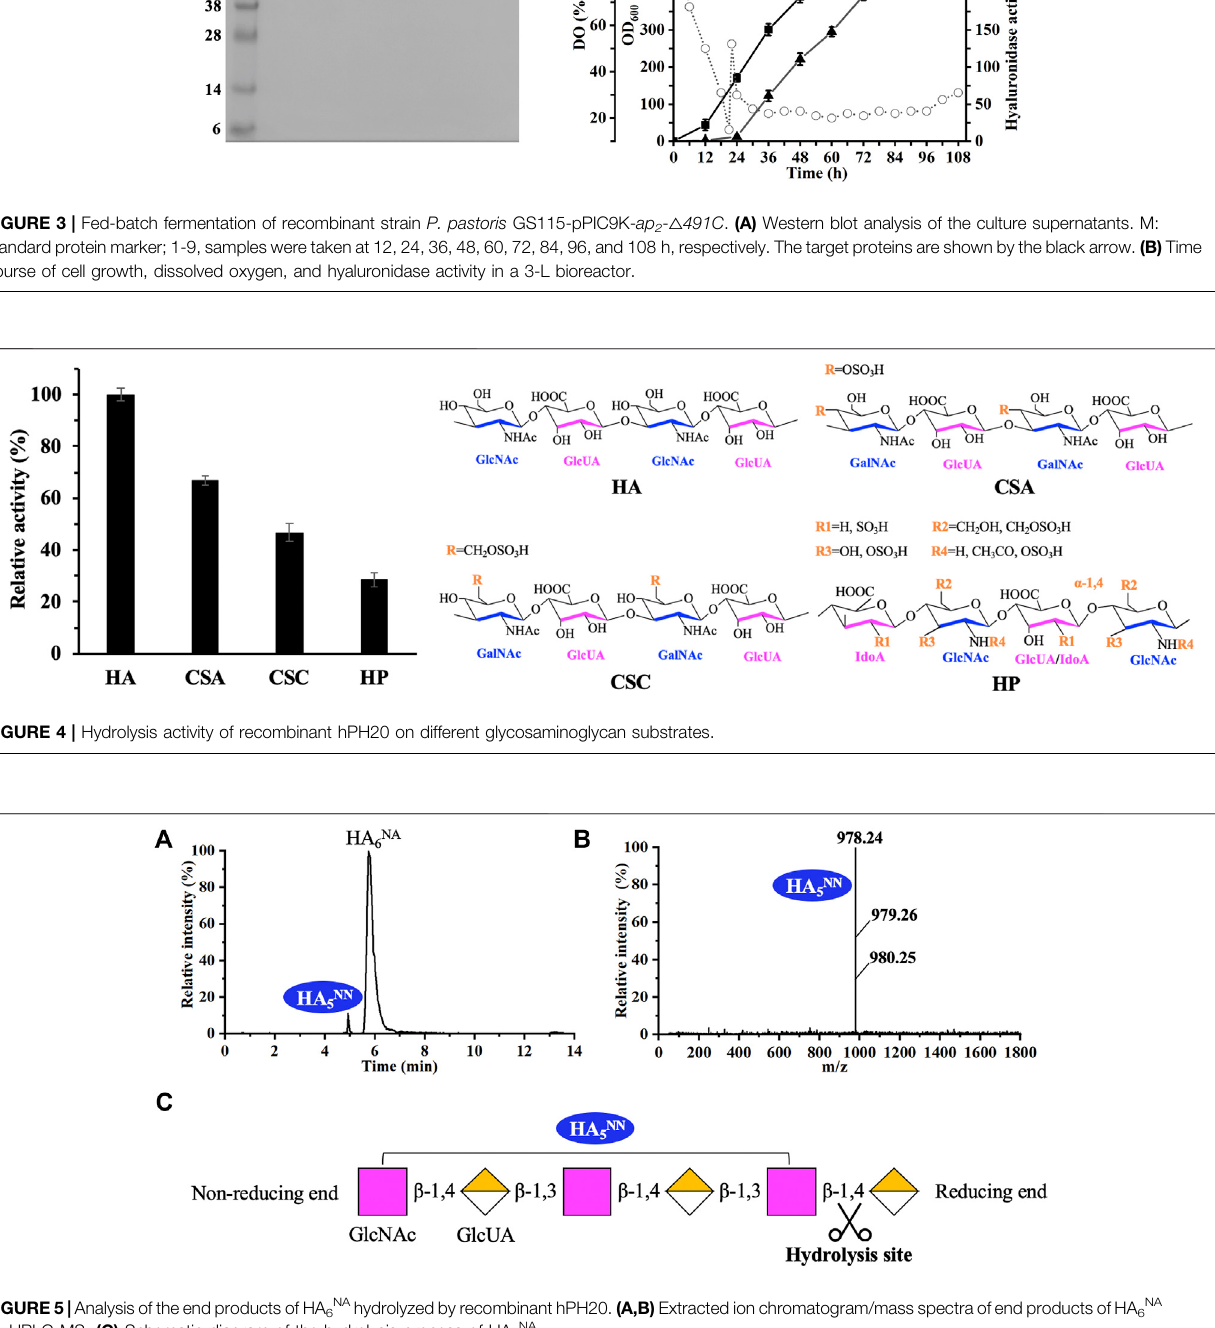
Frontiers in Bioengineering and Biotechnology |